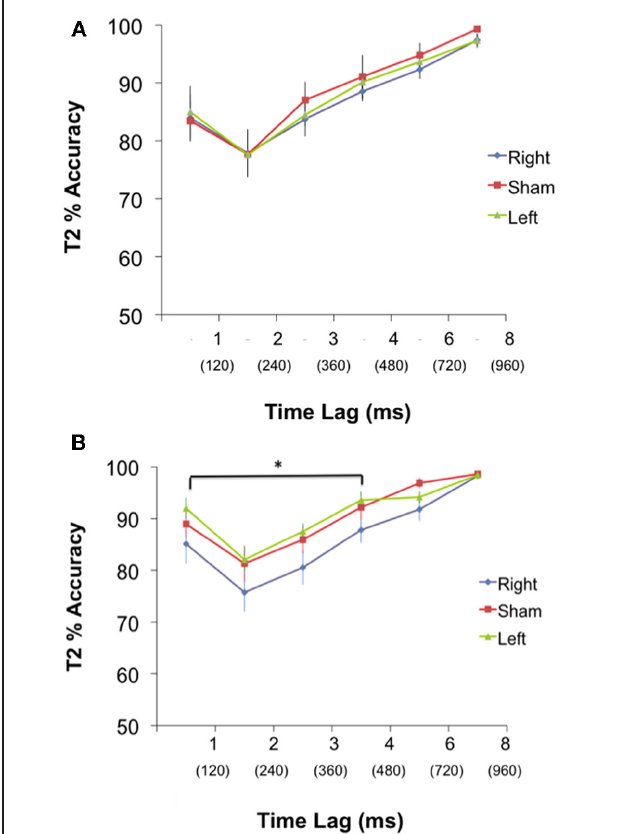
FIGURE 2 | (A) PRE: Performance (Mean % accuracy ± S.E.M) in detecting T2 for the Left, Right, and Sham group during pre-cTBS condition. There was no significant difference in performance between groups at any lag. Time between each lag was 120ms. (B) POST: Performance (Mean % accuracy ± S.E.M) in detecting T2 for the Left, Right and Sham group during post-cTBS condition. Paired contrasts reveal a significant difference between the right group and both the left and sham group for lags 1–4, ∗ p < 0 . 05. Time between each lag was 120ms, and T2 at lags 1–4 occurred within 480ms of